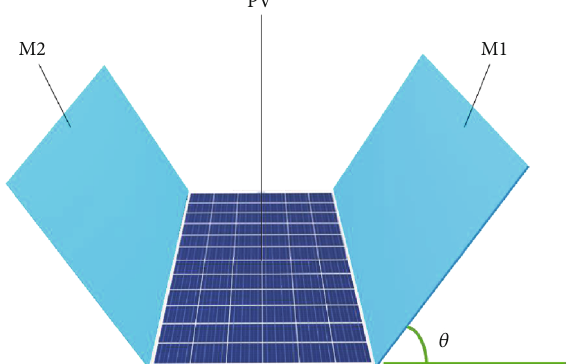
Figure 1: Schematic diagram of V-trough